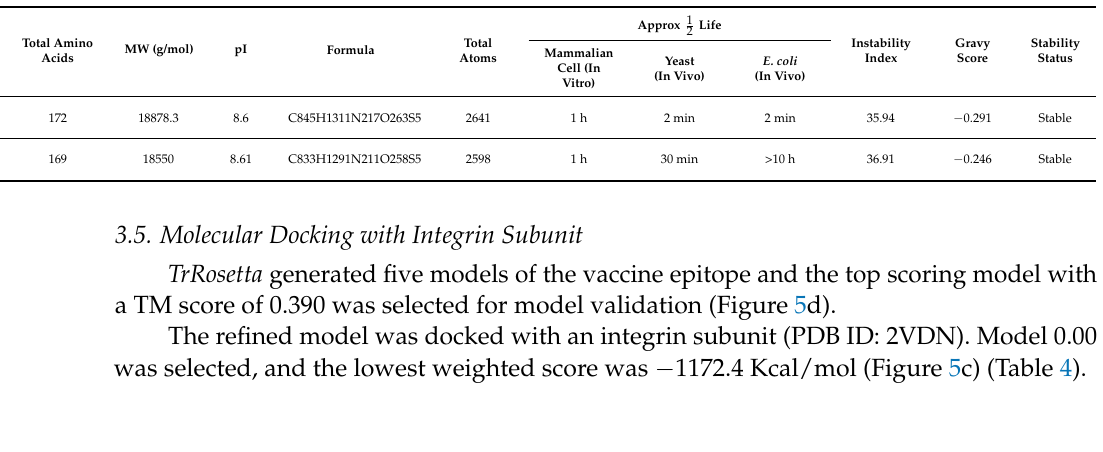
Table 3. Detail of the physiochemical properties of the vaccine construct.